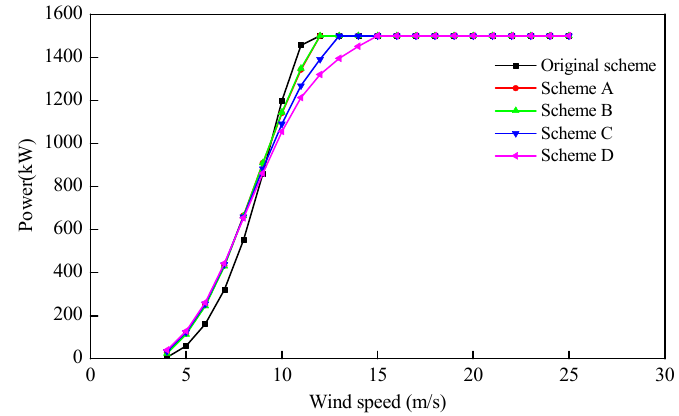
Figure 18. Comparison of power under different wind speed.